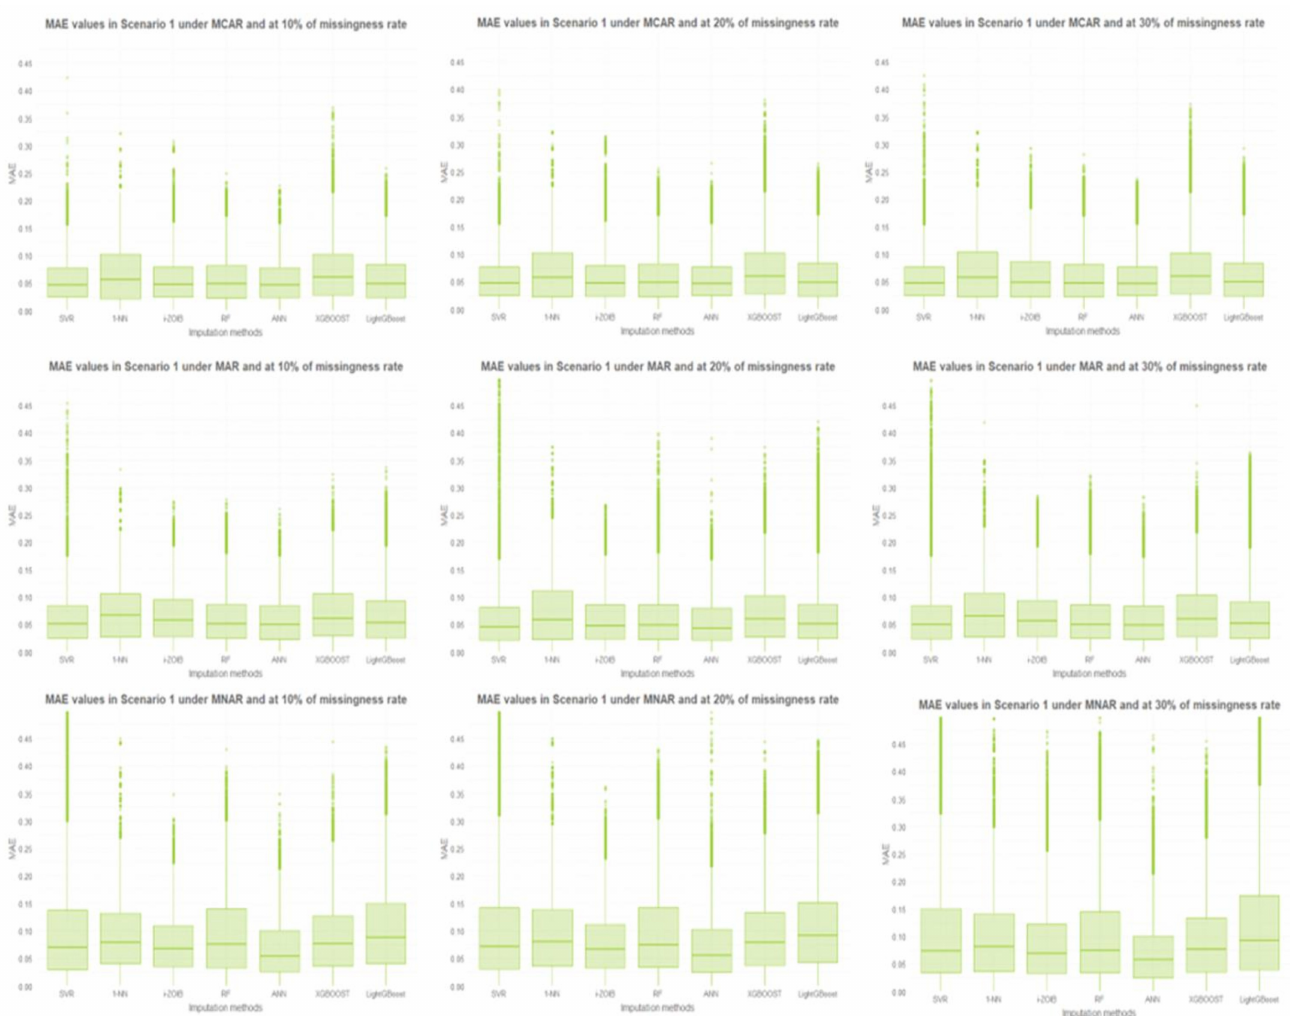
Figure 3. Boxplots of the MAE accuracy measure according to the missingness mechanisms, rates and imputation methods (from left to right: SVR, 1-NN, i-ZOIB, RF, ANN, XGBOOST, LightGBoost) in the Scenario